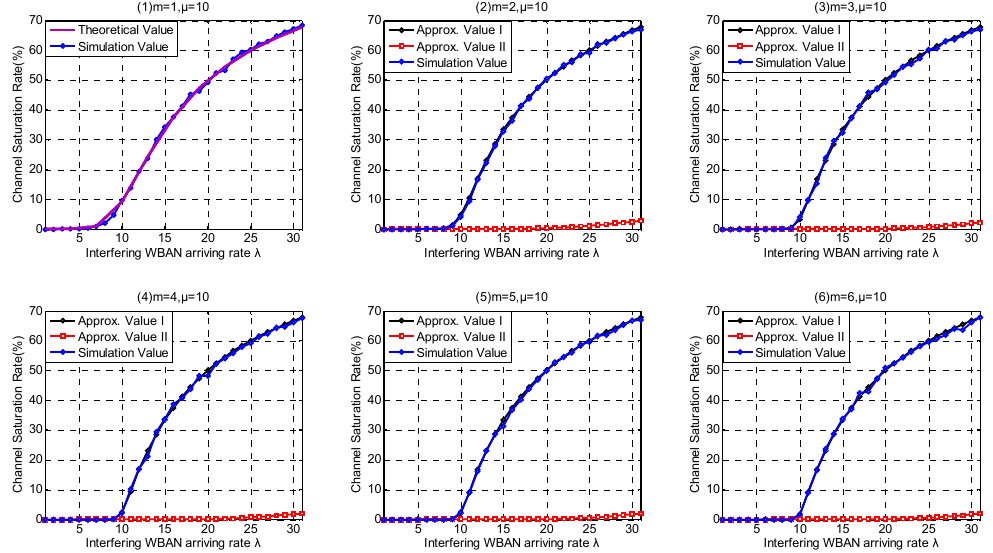
Figure 19. Channel Saturation Rate in Service-dependent coexisting